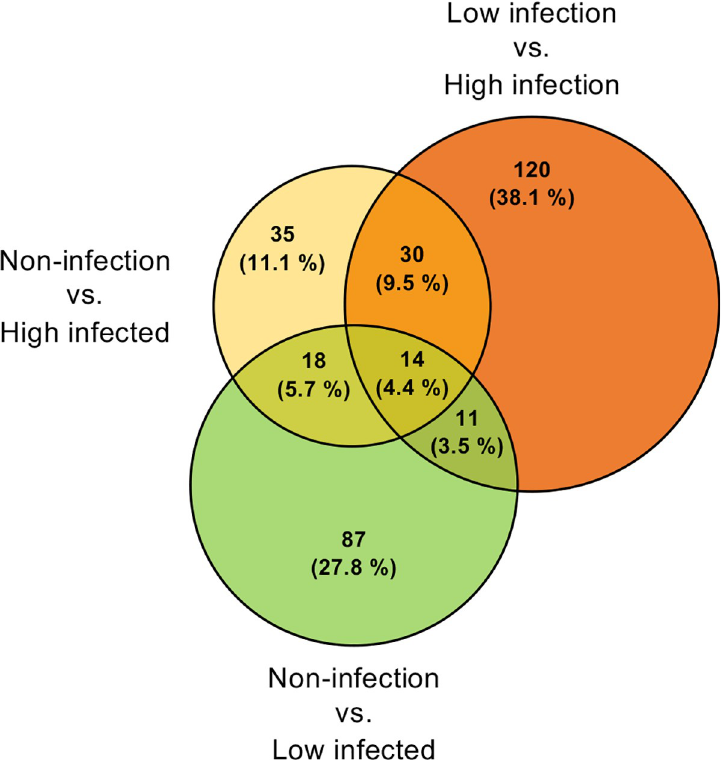
Fig 3. Dengue infection induces differential transcript abundances. Proportional Venn diagram depicting all pairwise comparisons (n = 402) among the antennal transcriptomes of non-infected, low and highly infected females (DENV-1 infection at 14 days post-infection). Overlapping regions represent the subsets of transcripts that are shared among the different conditions. Significant enhancement was determined as a fold change of greater than 1.5, and an FDR-corrected p-value < 0.05 in pairwise